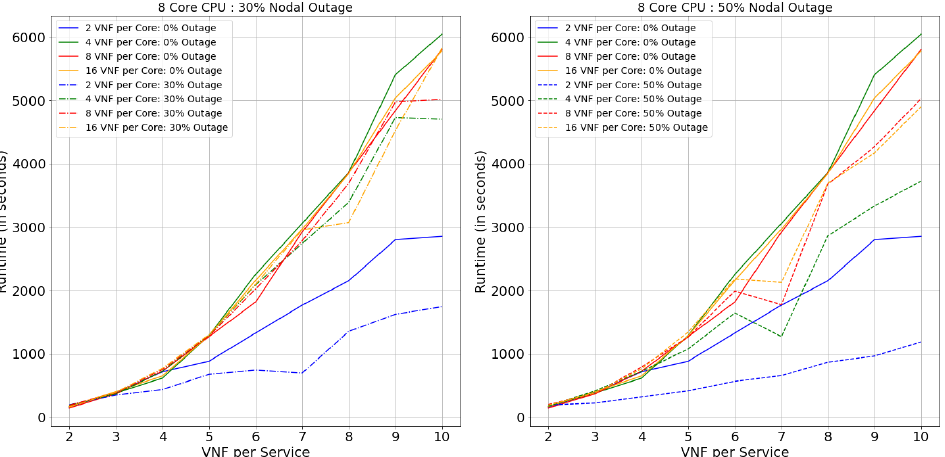
Figure 26. Runtime: BtEurope topology with nodal outage—4 core CPU.